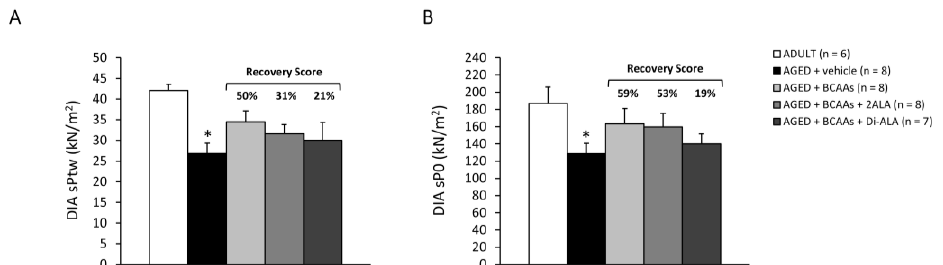
Figure 6. Maximal specific isometric twitch ( A , sPtw; kN/m 2 ) and tetanic ( B , sP0; kN/m 2 ) force measured in DIA muscles isolated from ADULT mice and AGED mice treated with vehicle, BCAAs, BCAAs + 2ALA or BCAAs + Di-ALA. All values are expressed as mean ± SEM for the number of mice indicated in brackets. For both parameters, a statistically significant difference was found via an unpaired Student’s t -test for AGED + vehicle vs. ADULT mice (*; 0.0004 < p < 0.01). No statistically significant differences were found among AGED mice groups via a one-way ANOVA followed by Dunnett’s post hoc test. The recovery scores (R.S.) towards ADULT values, calculated for each treated group, are indicated above the bars.